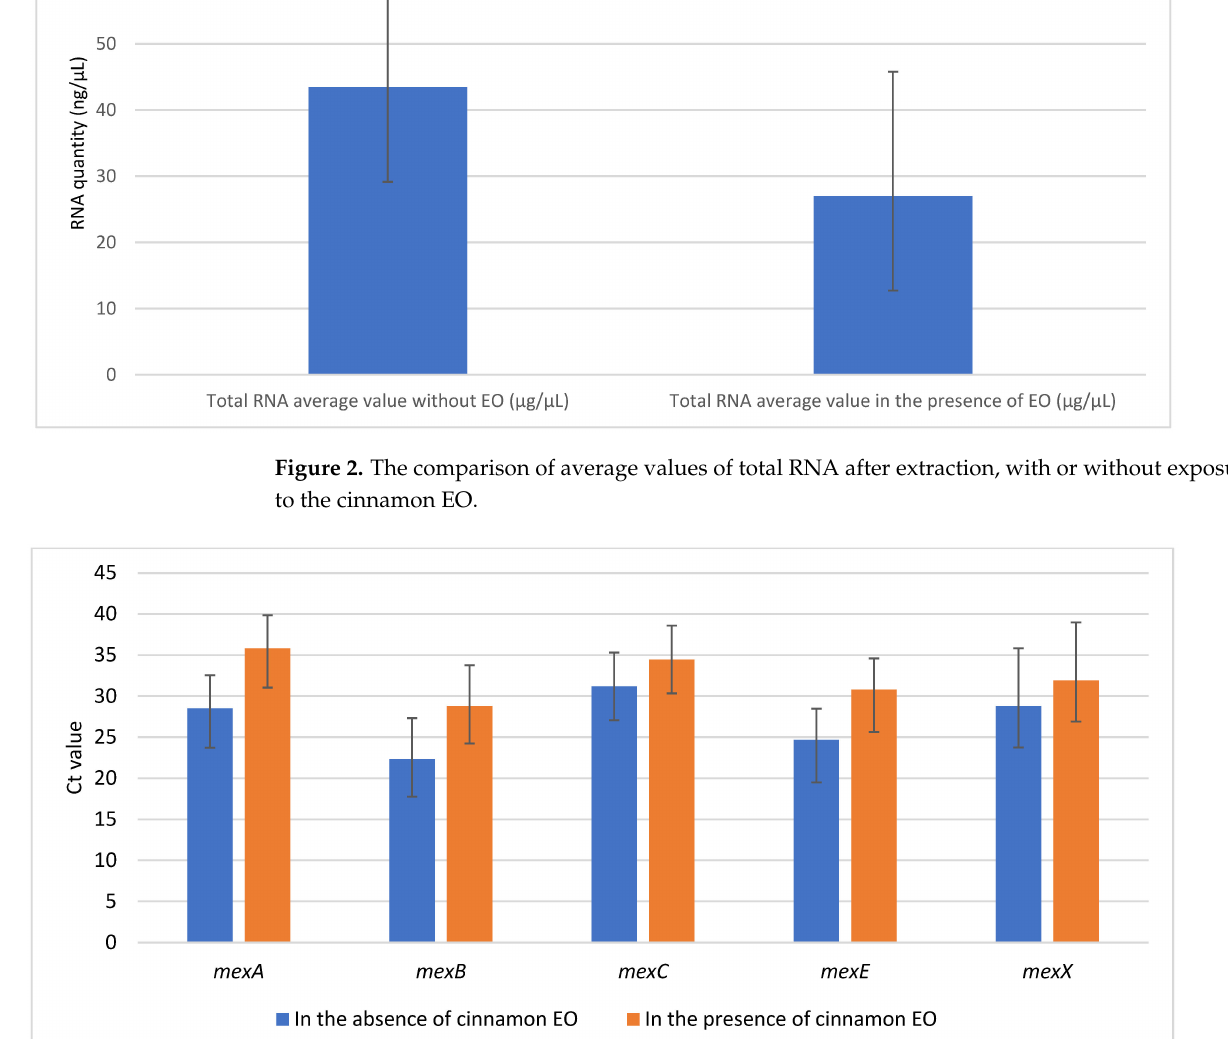
Figure 3. The comparison of average values of Ct in the presence and absence of cinnamon EO. The error bars represent the variability of Ct values among the 15 tested isolates using real-time